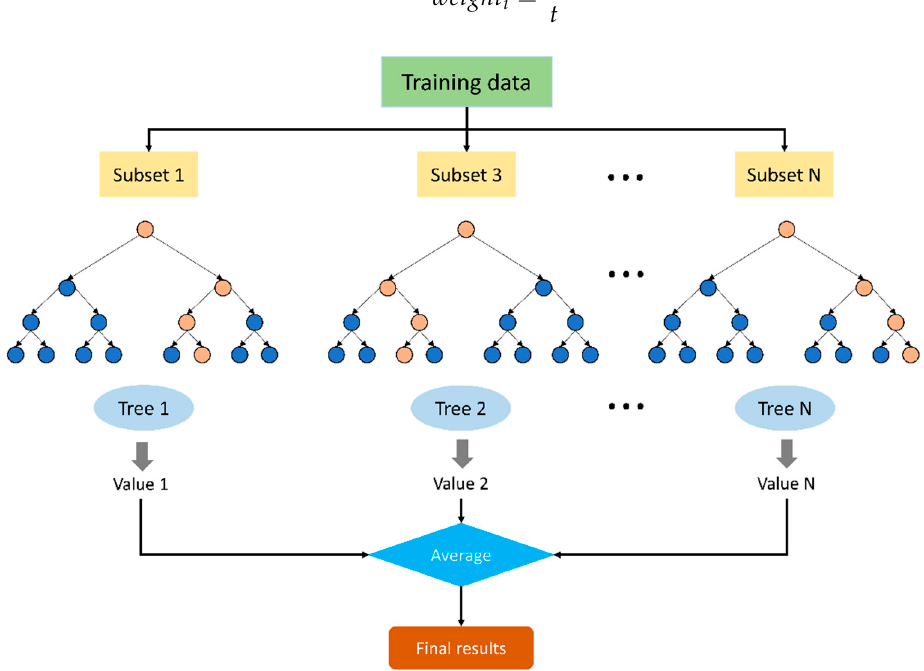
Figure 1. Schematic diagram of the RF model.